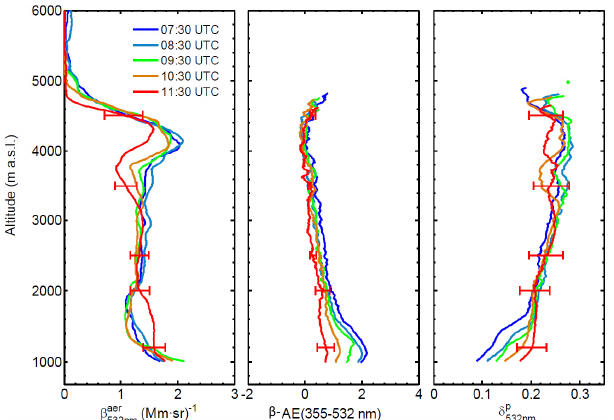
Figure 3. Profiles of (a) aerosol particle backscatter at 532nm ) (b) backscatter-related Ångström exponent between 355 ( β aer 532nm and 532nm ( β -AE(355–532nm)) and (c) linear particle depolar- ) retrieved from lidar elastic mea- ization ratio at 532nm ( δ P 532nm surements at different hours between 07:30 and 11:30UTC on the morning of the 27 June